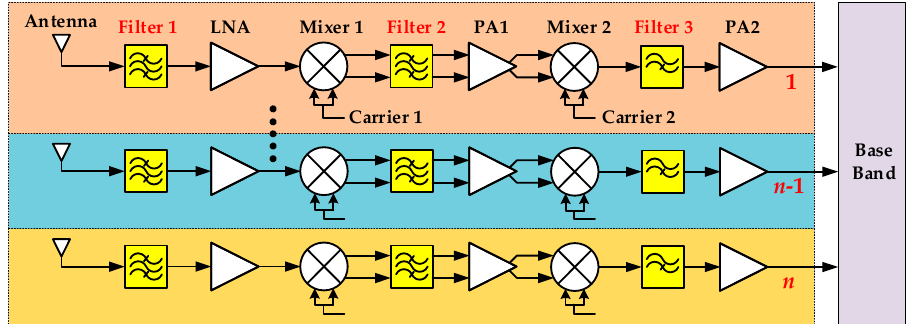
Figure 1. Diagram of a typical multi-function wireless system with multi-channel receivers.